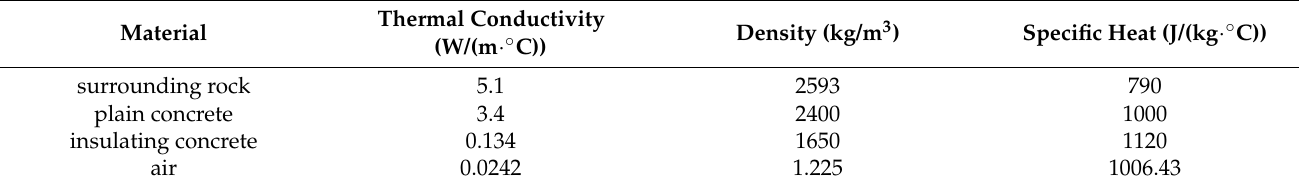
Table 8. Thermophysical parameters of the surrounding rock, the support, and the